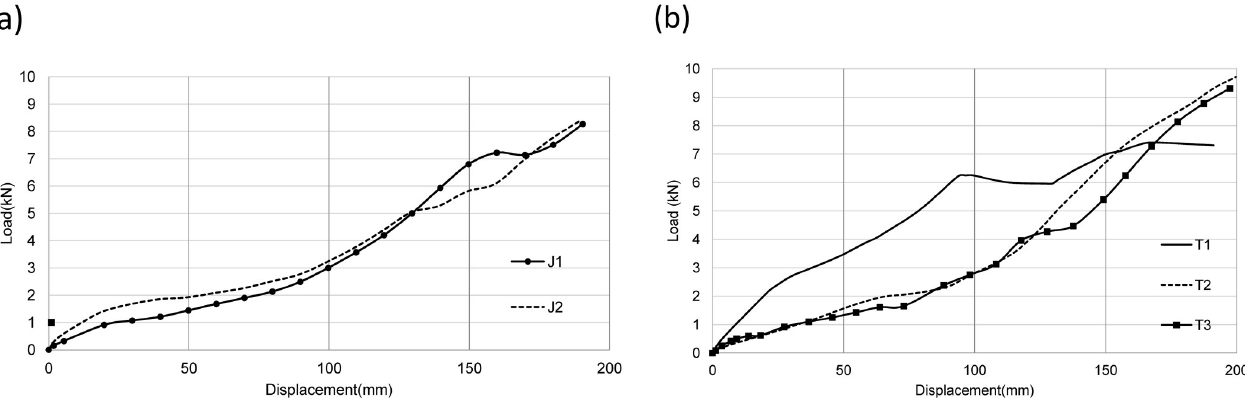
Fig 7. Load-displacement curves. (a) J group;(b) T group.